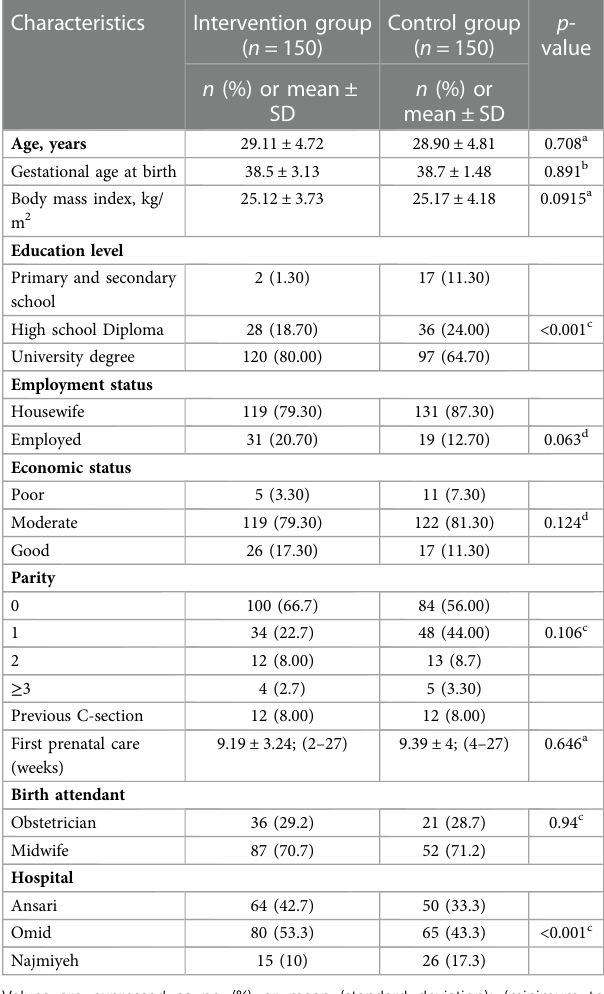
TABLE 1 Baseline demographic and obstetric characteristics of intervention and control groups. Characteristics